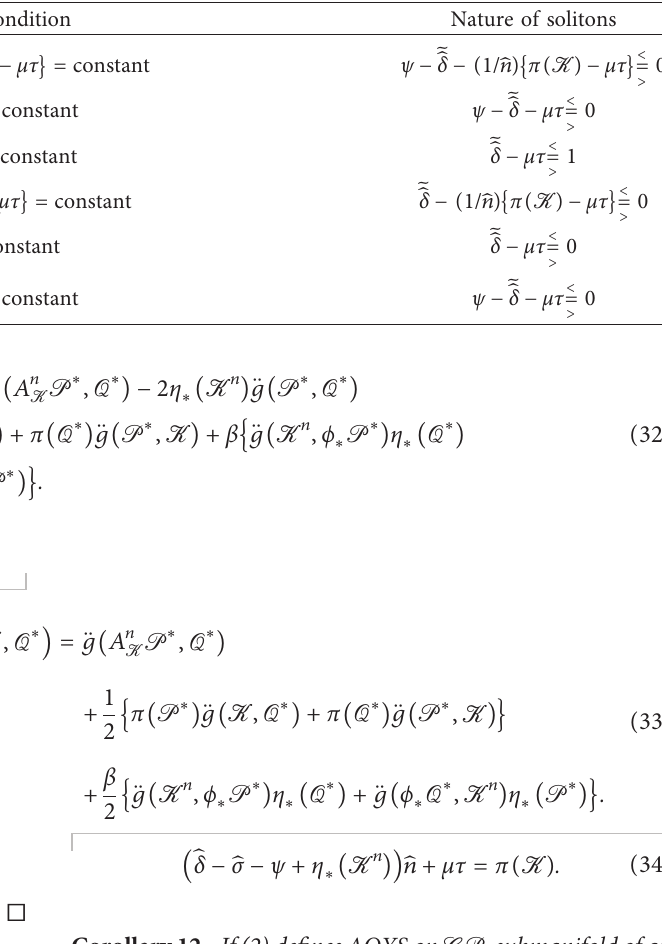
Table 6: Relationship between K , existence condition, and nature of